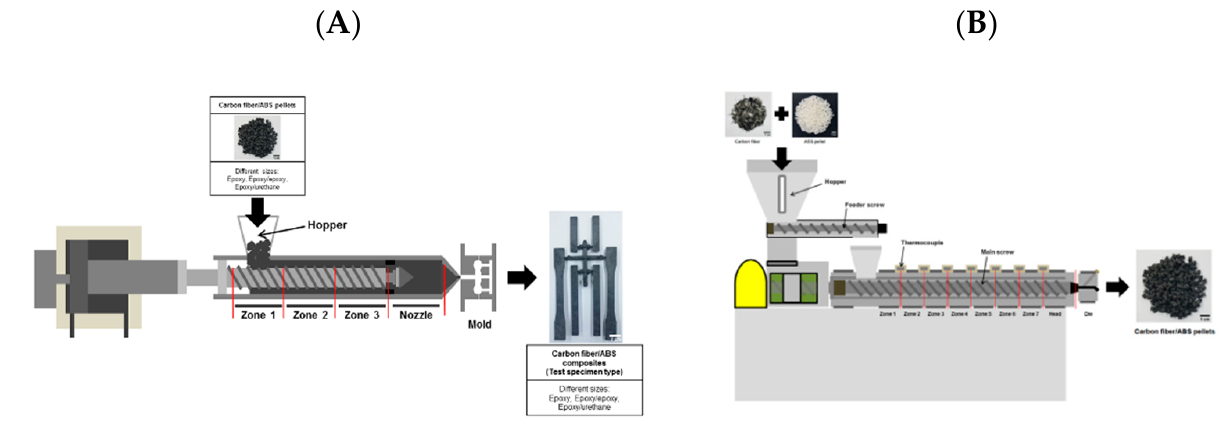
Figure 1. Schematics of extrusion process for preparing ( A ) carbon fiber/ABS pellets and ( B ) injection molding process for preparing carbon fiber/ABS composites.